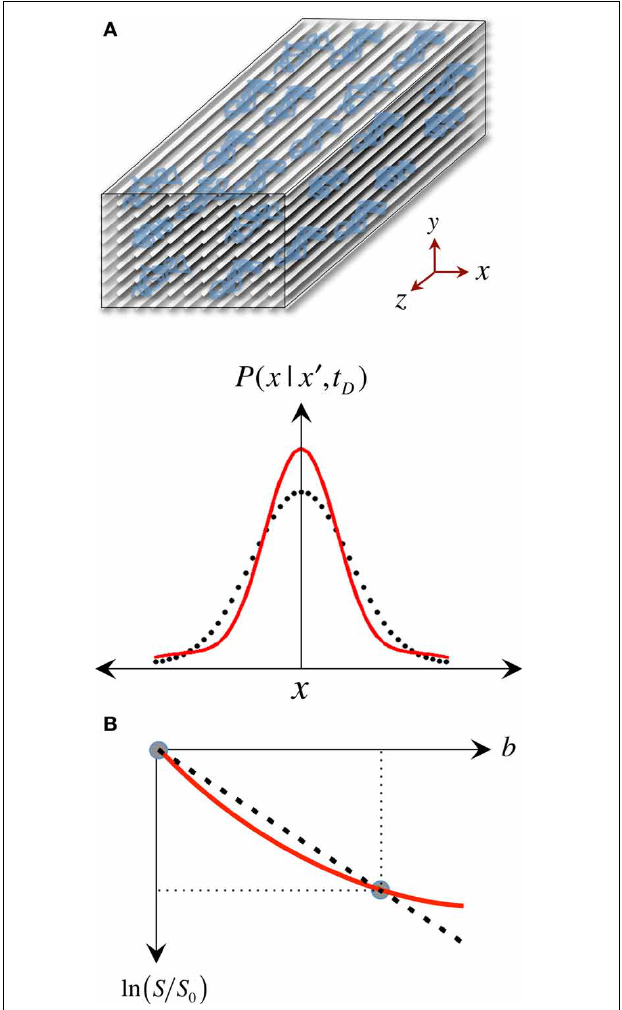
FIGURE 4 | The approximate nature of the “single tensor” model. (A) “Restricted” diffusion processes such as those in white matter result in displacement probabilities that are no longer accurately described by a Gaussian “bell.” (B) Therefore, the assumption that the signal attenuation must have a linear relationship in a logarithmic scale with the b -value is no longer valid, resulting in tensor diffusivities that are “apparent” (i.e., model approximations) rather than “true” measures of restricted